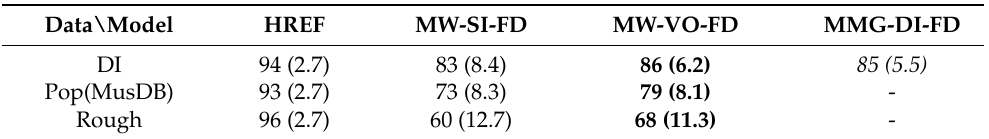
Table 5. Average rating and standard deviation for the perceptual evaluation of the perceived difference between original and resynthesis for different variants of the MBExWN model and a multi- band MelGAN